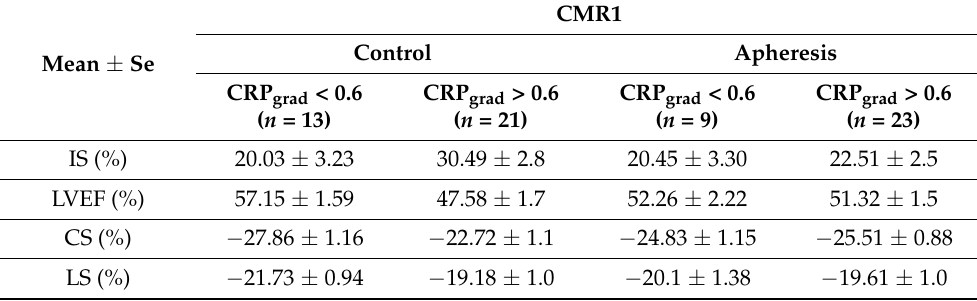
Table 3. Dose-Dependent Effect of CRP regarding CRP gradient cut-off of 0.6